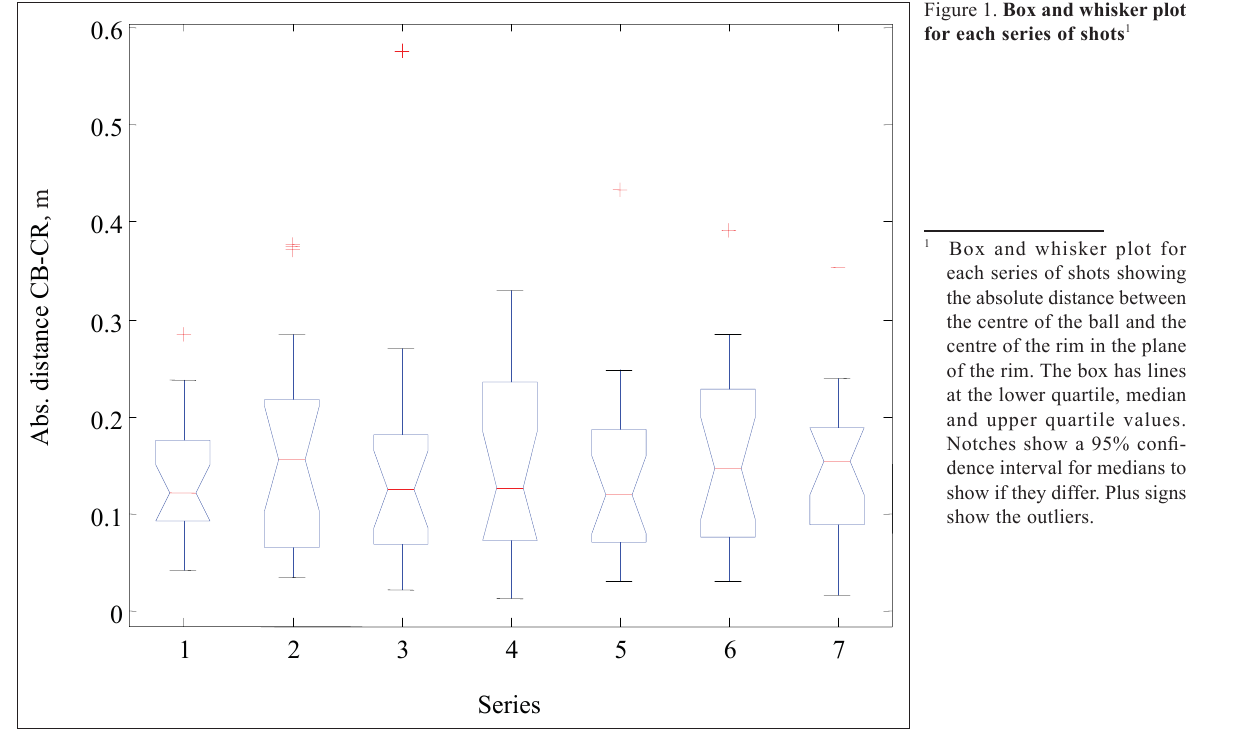
Figure 1. Box and whisker plot for each series of shots 1